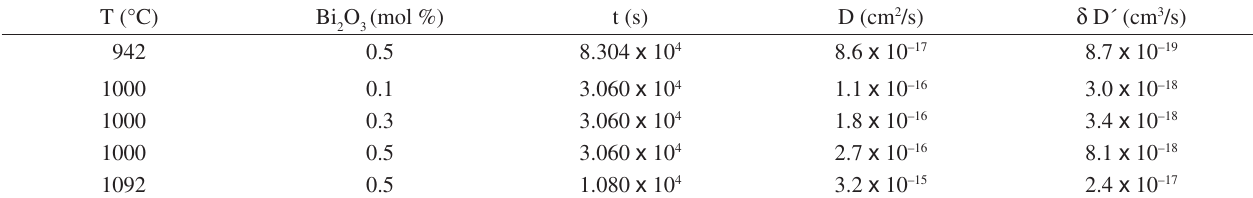
O -doped ZnO. PO 2 3